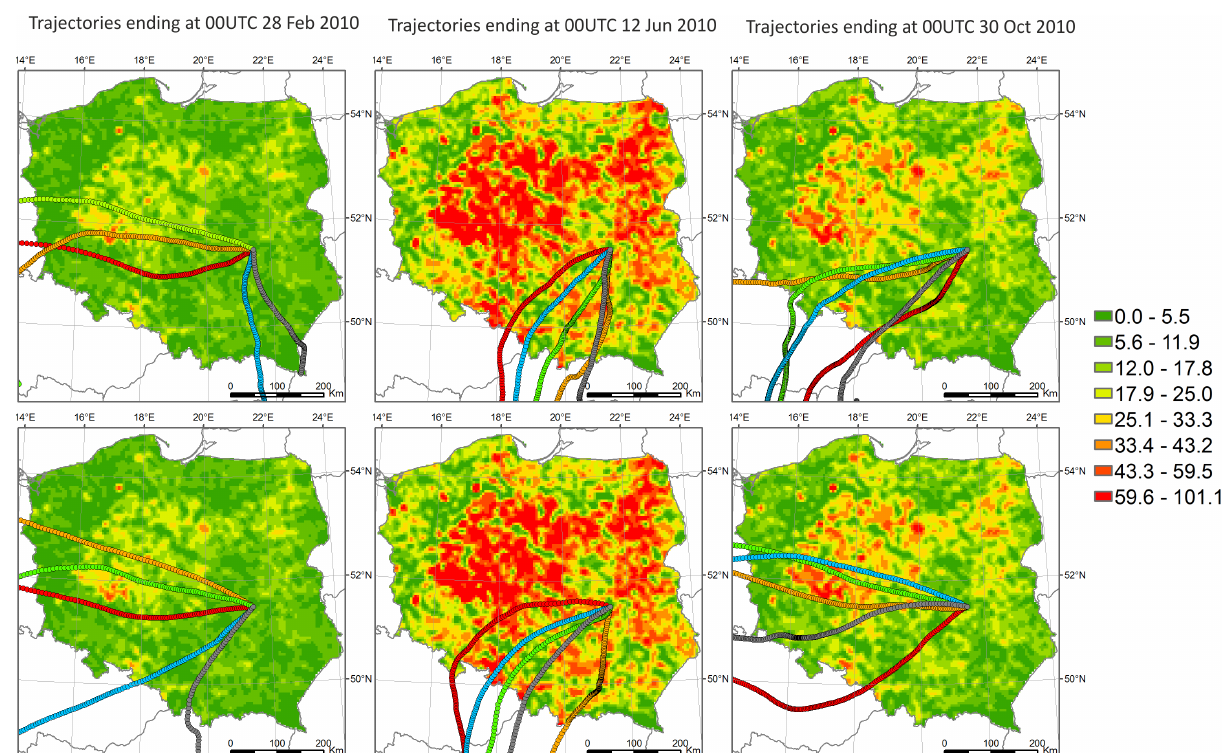
Figure 8. 36h backward trajectories ending in Jarczew during episodes (25–27 February 2010; 09–11 June 2010; 10–29 October 2010) with high NH 3 measured concentrations. The first trajectory (gray) starts at 12.00 of the first day of each episode, and then starts every 6h, and are presented in the following colours: blue, green, orange, red. Spatial distribution of modelled ammonia emission during the episodes (unit: gha − 1 48h − 1 )